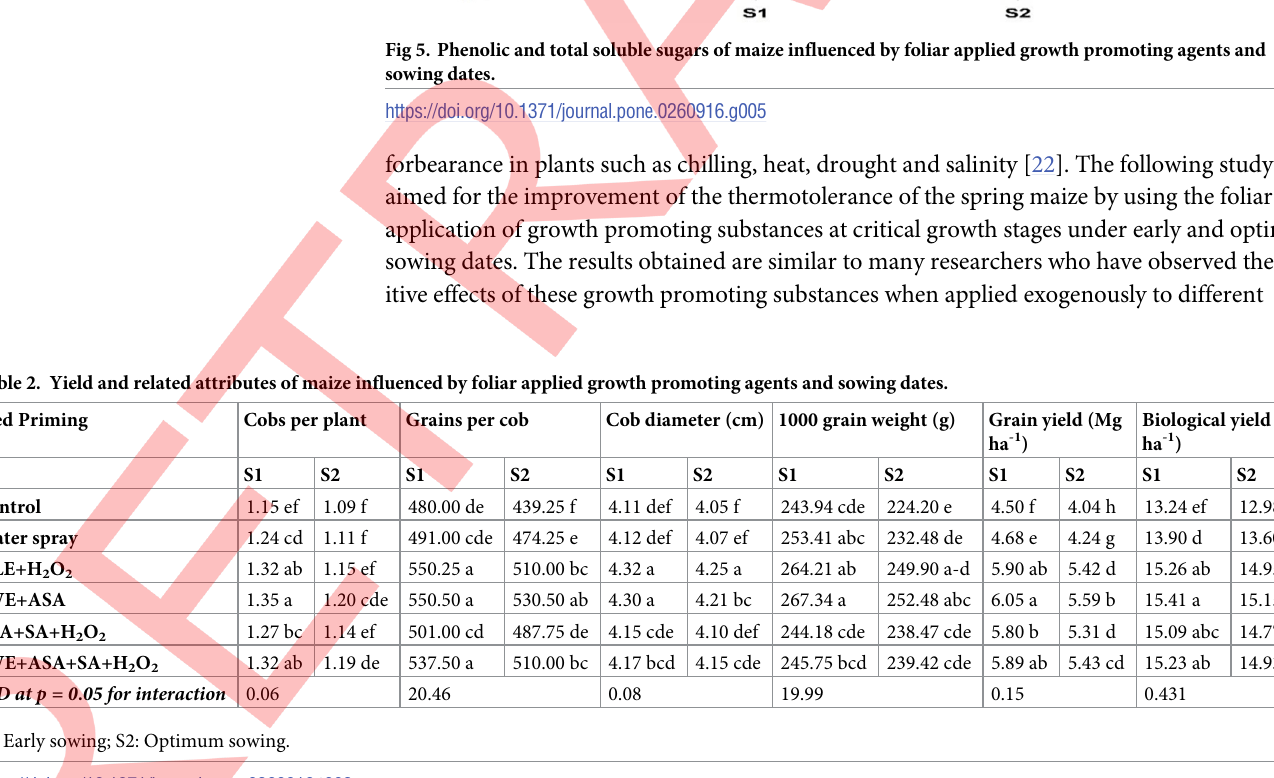
Fig 5. Phenolic and total soluble sugars of maize influenced by foliar applied growth promoting agents and sowing dates.